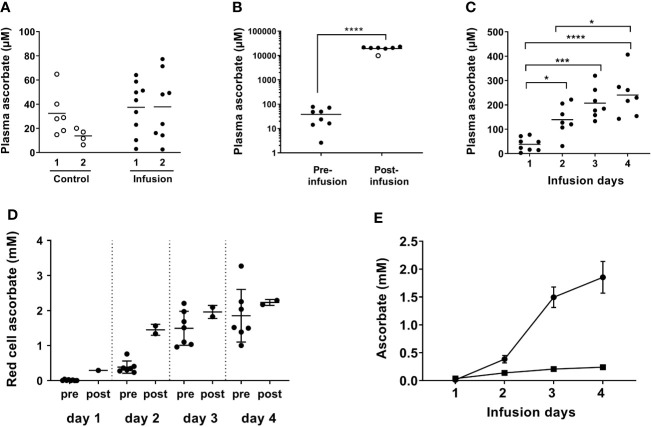
Plasma and red blood cell ascorbate levels in patients at baseline, immediately post-infusion and over the course of high dose ascorbate infusion. IVC was administered daily for 4 days and blood taken pre- and post-IVC infusion as indicated. The first infusion comprised 25 g ascorbate and subsequent infusions were at 1 g/kg body weight, with a maximum of 75 g. (A) Baseline plasma ascorbate from patients in the control (○) and infusion (⬤) cohorts at colonoscopy (1) and at surgery (2) (control patients) or immediately prior to first infusion (Infusion patients). Horizontal bars show the mean value. (B) Plasma ascorbate in samples taken prior to first infusion and immediately after infusion with high dose ascorbate. Horizontal bars show the mean value. (○) sample following 25 g infusion. ****p < 0.0001 (unpaired t-test). (C) Plasma ascorbate immediately prior to consecutive high dose ascorbate infusions on days 1–4. Horizontal bars show the mean value. Significant differences were observed between day 1 plasma ascorbate and the subsequent days ***p < 0.005, ****p < 0.0001 (unpaired t-tests). There was a significant difference between concentrations at days 1 and 4, *p < 0.05 and a one-way ANOVA indicated a significant difference between days 1 and 4, p < 0.0001. (D) Red cell ascorbate concentrations pre- and post-infusion; means ± SD. Unpaired Student’s t test showed no significant differences between red cell ascorbate concentrations on day 2 post-infusion and pre-infusion day 3, and post-infusion day 3 and pre-infusion day 4. (E) Plasma (▪) and red cell (⬤) ascorbate concentrations measured prior to infusion each day; means ± SD. A mixed-effects model indicated a significant difference between days, with day 1 different to day 2, 3, and 4; p < 0.005 for red cells and p < 0.05 for plasma.